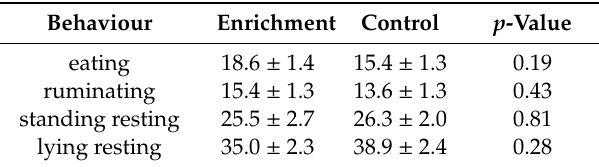
Table 3. Mean time budgets (% ± SEM) of each behavioural category in enrichments and control animals in Trial 1.